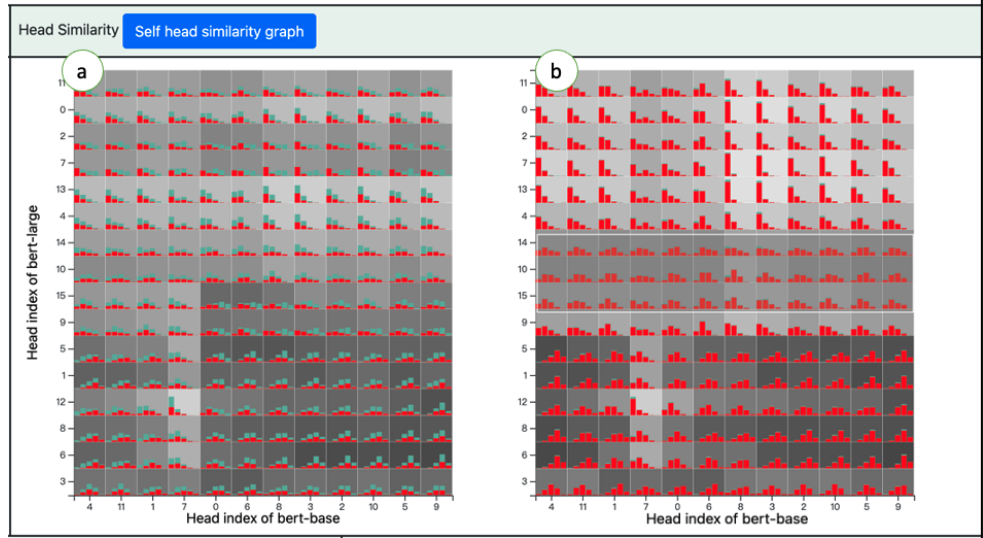
Figure 11. ( a ) is the head similarity graph calculated from all instances. ( b ) is the filtered head similarity graph calculated from the instances selected in the scatter view. The user can brush a region of heads in the filtered head similarity graph, our system will track the evolution of these attention words through the brushed heads and shows the result in the attention